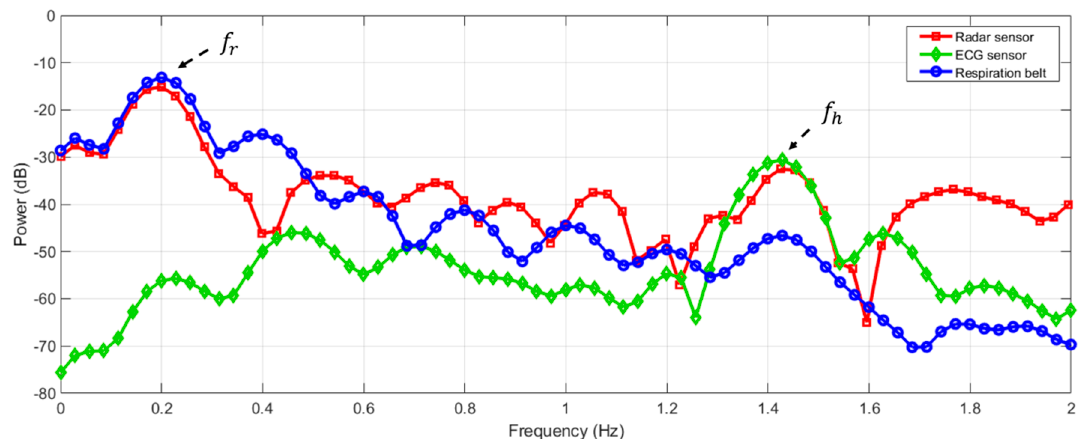
Figure 10. Vital-signs spectra measured using the proposed 915 MHz CW radar sensor, the respiration belt, and the ECG sensor.